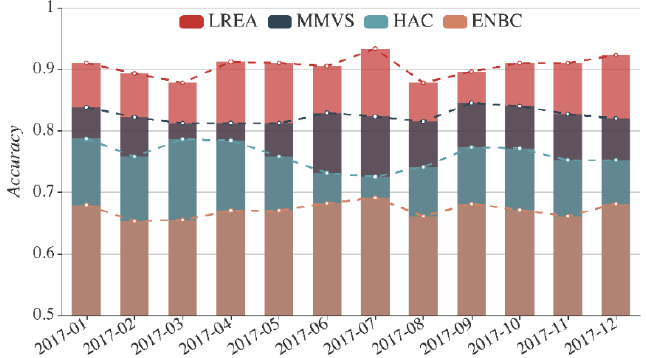
Figure 20. Monthly average evaluation accuracy rates of region 1 r in 2017 with the four methods. In Figure 20, the horizontal axis encompasses different months, the vertical axis indi- cates the monthly average evaluation accuracy rates, the four tops of each colored column represent the accuracy rates of the four methods. Taking July 2017 as an example, we can see that the four columns in different colors from high to low correspond to LREA, MMVS, HAC, and ENBC, with the accuracy rates standing at 93.3%, 82.3%, 72.5%, and 69.1%, re- spectively. Overall, the four methods are ranked by the accuracy rates in descending or- der: LREA, MMVS, HAC, and ENBC. The annual accuracy rates of evaluation results ob- tained with LREA, HAC, ENBC, and MMVS come at 90.5%, 82.5%, 76.0%, and 67.1%. Figure 21. Evaluation accuracy rates of 34 local regions in 2017 with the four methods. Figure 21 shows that the horizontal and vertical axes represent the single region and the annual evaluation accuracy rates, respectively. All local regions under monitoring see their average evaluation accuracy rates obtained with LREA, MMVS, HAC, and ENBC standing at 84.2%, 78.6%, 71.6%, and 63.5%, respectively. From Figures 19 and 20, it is obvious that LREA is superior to MMVS, HAC, and ENBC in terms of evaluation accuracy rate. (3) The application system of the evaluation of the dam operation state To further illustrate the evaluation results of the dam operation state, we have devel- oped and implemented an application system for the evaluation the dam operation state, as shown in Figure 22. Figure 22a,c show the evaluation results under the situation of the lowest water level in 2013 and 2015, respectively. Figure 22b,d show the results in the highest water level in 2014 and 2016, respectively. From Figure 22a–d, they illustrate the different evaluation results of the central section of the dam from the lowest water level to the highest water level when the measured values continue to change over time.